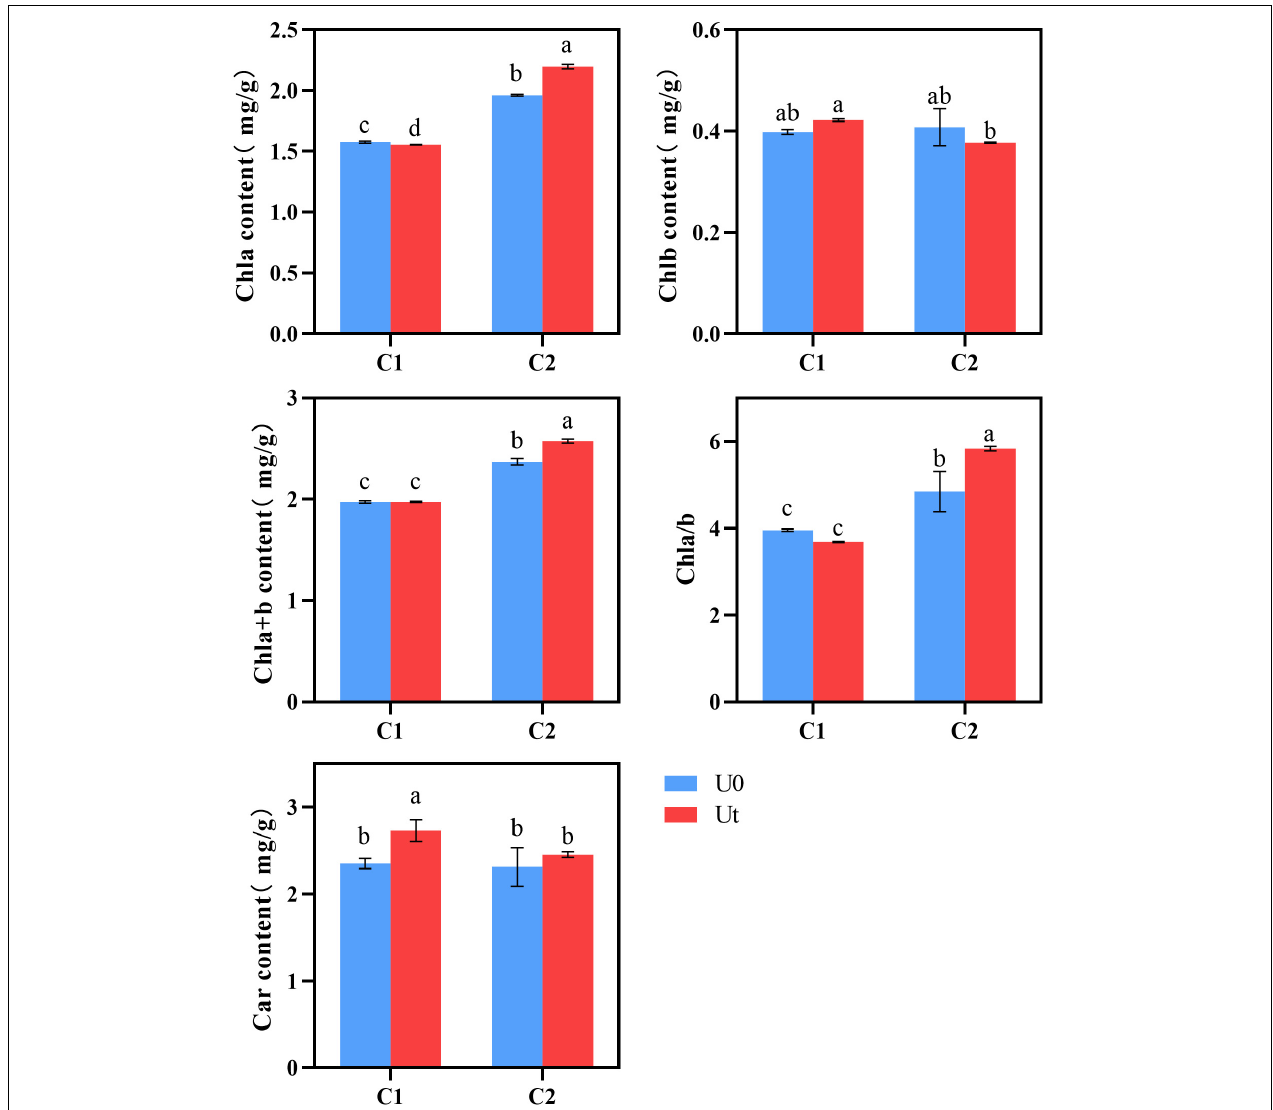
FIGURE 4 | Photosynthetic pigment of two Angelica sinensis cultivars in response to enhanced UV-B radiation. Different letters indicated the significant difference ( P < 0.05). Error bars were represented standard deviation